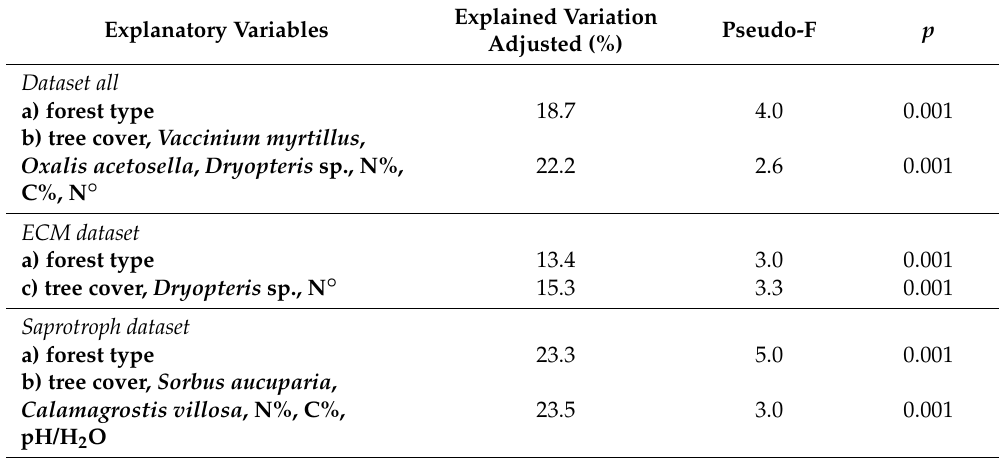
Table 3. Variation in the fungal community based on the number of sequences using RDA; environmental variables used as explanatory variables: a ) forest type as an explanatory variable, b ) environmental variables excluding forest type, and c ) all environmental variables (N%, nitrogen content; C%, carbon content; N ◦ , north latitude) in forests: K1 = attacked by bark beetle; K2 = destroyed by bark beetle; DES = with removed trees; REF =